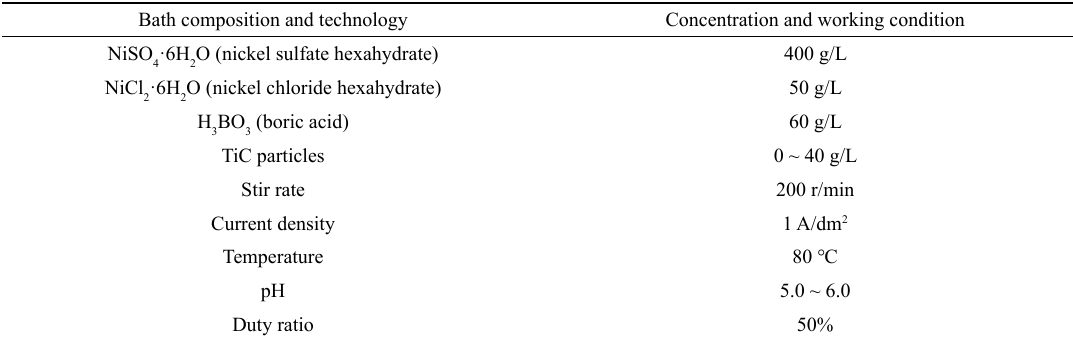
Table 1. Electrodeposition bath composition and process parameters Bath composition and